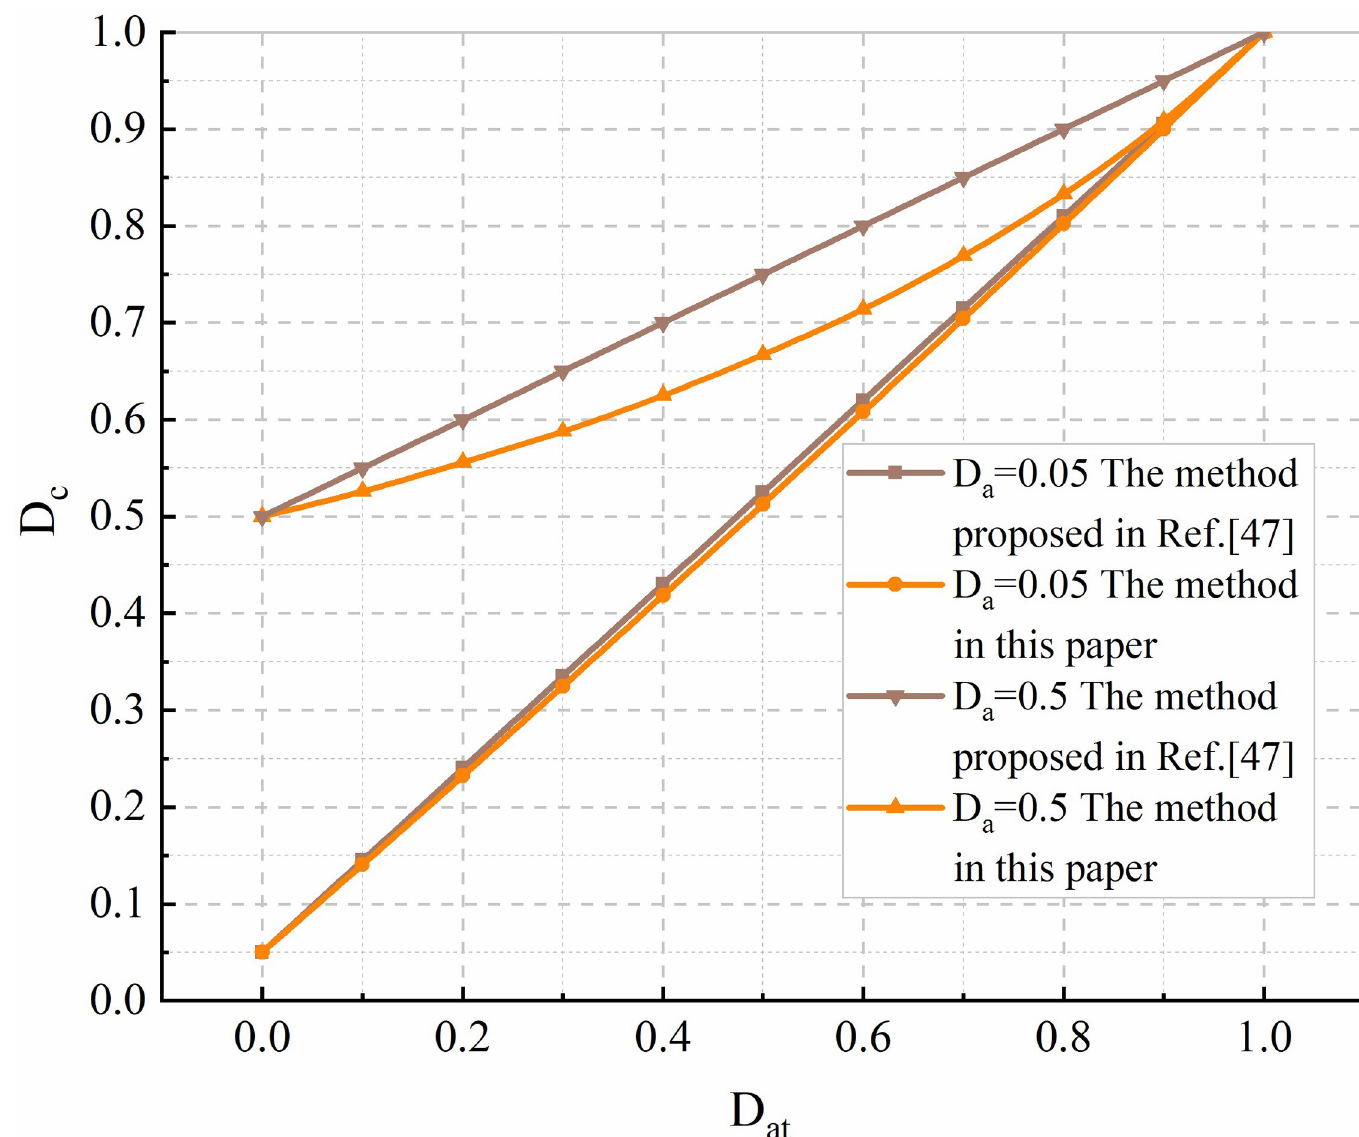
Fig 3. Schematic diagram for comparison of coupling